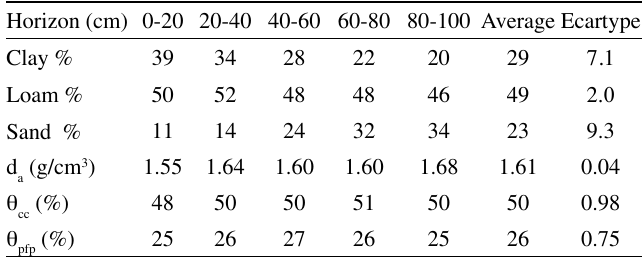
Table 2 - Soil characteristics of the olive